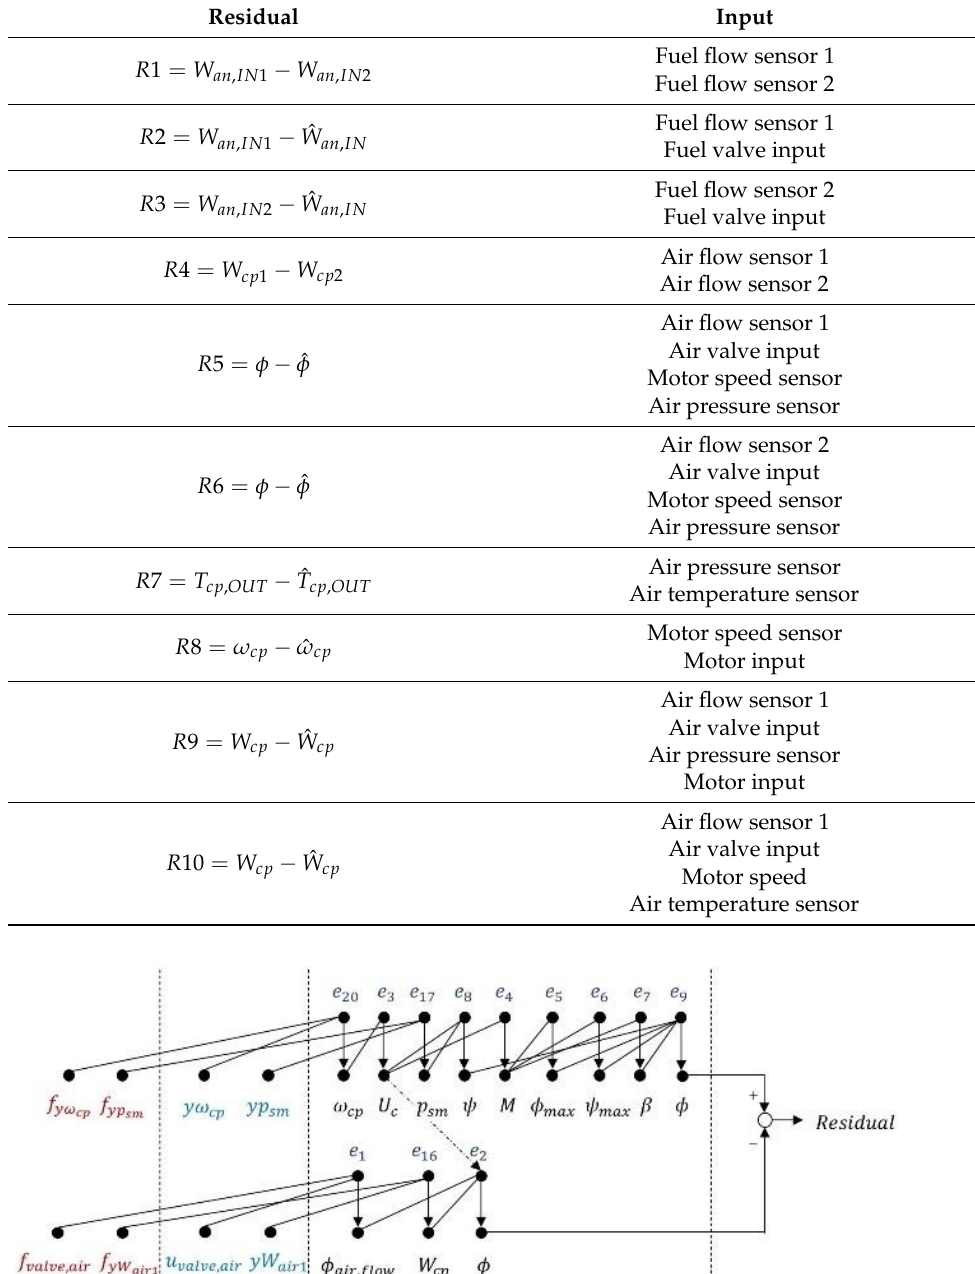
Table 3. List of residuals obtained and respective inputs.